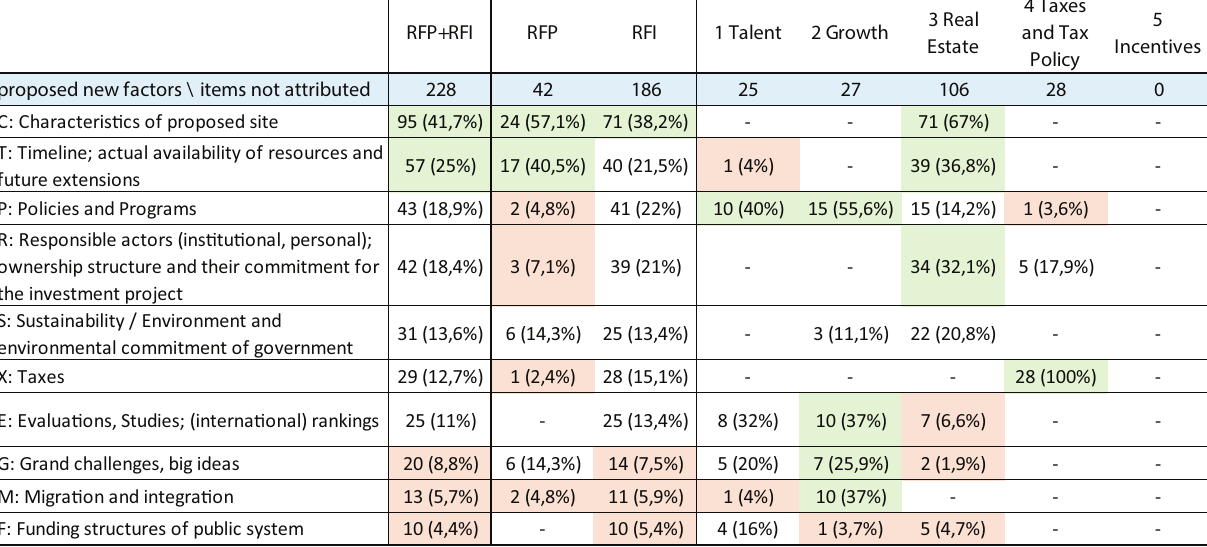
Figure 9. Attribution of ten additional criteria to 228 items previously not